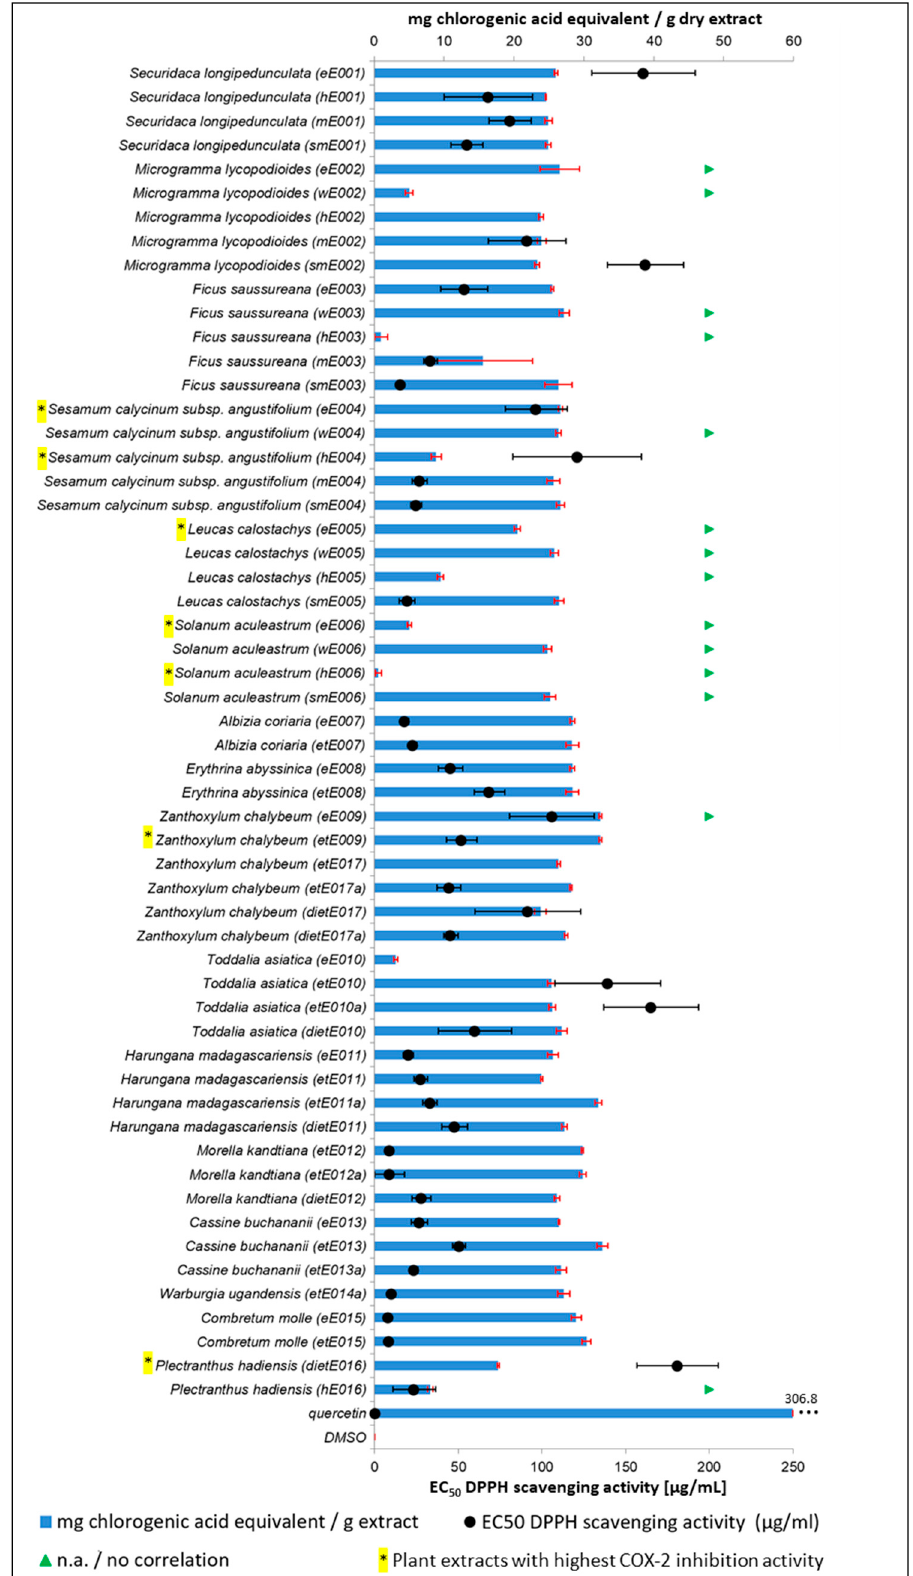
Figure 6. Results of the in vitro investigation of antioxidant activity (free radical scavenging activity) and determination of TPC for assessment of potential mechanism of action of the COX-2/1 and 15-LOX inhibition activity; plant extracts identified in the initial library COX-2 screen for COX-2/COX-1 dose-response inhibition experiments are marked with *; n.a. = not available.